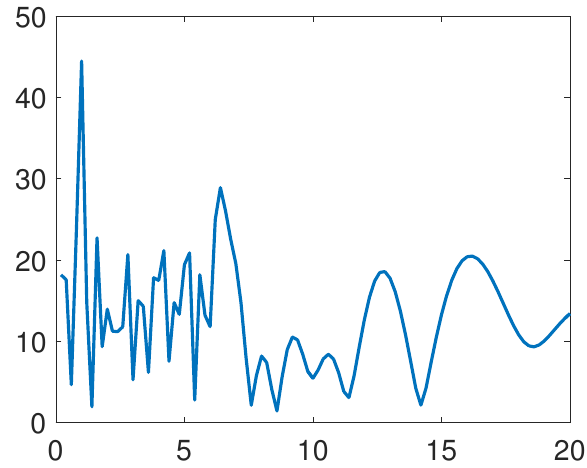
Figure 12. The spectrum of oscillations of the dynamic ice growth rate averaged over the area of CA in Figure 5g. The horizontal axis represents the oscillation period in years, vertical axis—the amplitude of the harmonic